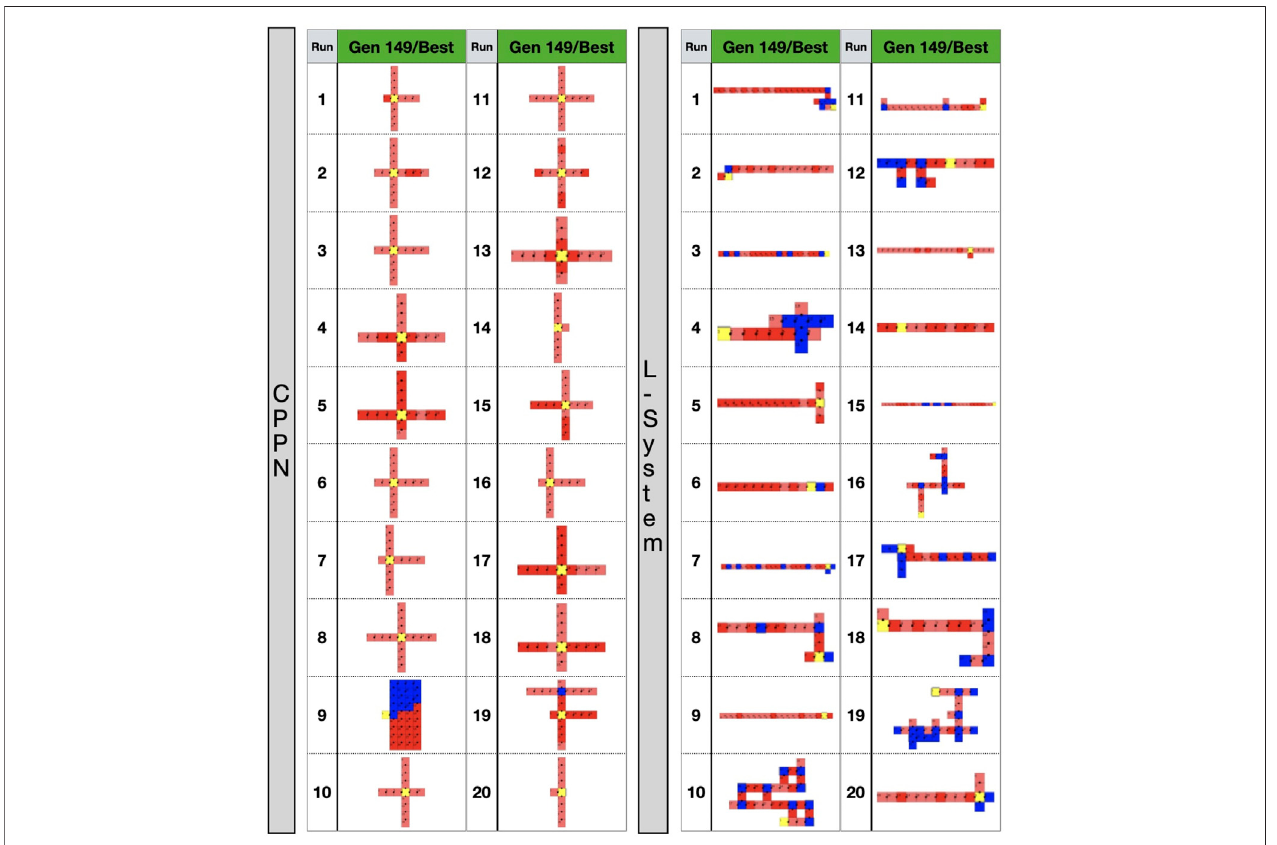
FIGURE 12 | Best robots after optimization in experiment